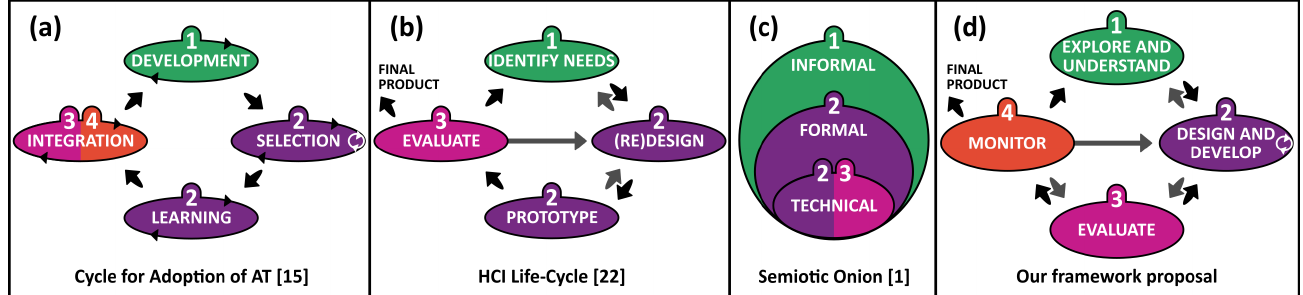
Fig. 2. Framework proposal architecture [31].